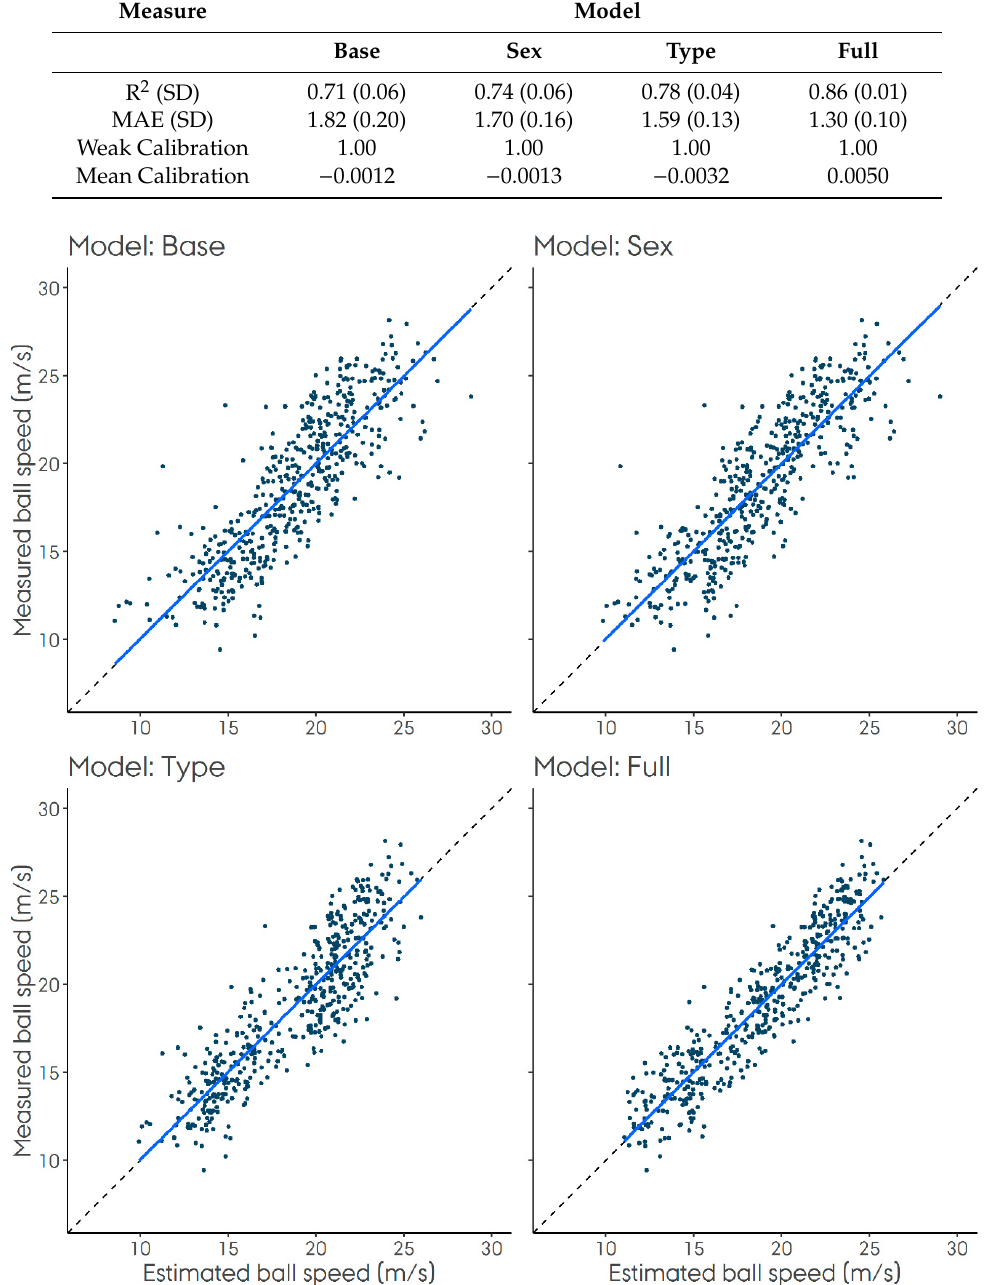
Figure 1. Calibration plots showing estimated vs. observed speeds. The solid, blue line represents the calibration line and the dashed line (only visible at the ends of the solid line) represents a 45° line. Table 2. Performance measures for all models. SD = standard deviation, MAE = mean absolute error.